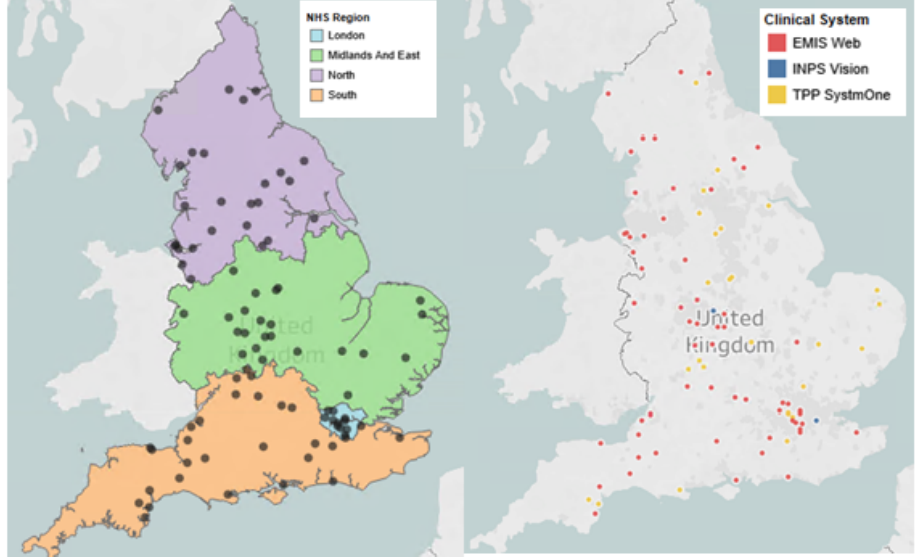
Figure 1. RCGP RSC virology sampling sites. Distribution by National Health Service region and by brand of computerized clinical systems supplier. RCGP RSC has 100 virology sampling sites, there are >500 practices in total signed up to RCGP RSC across England. NHS: National Health Service. RCGP: Royal College of General Practitioners; RSC: Research and Surveillance